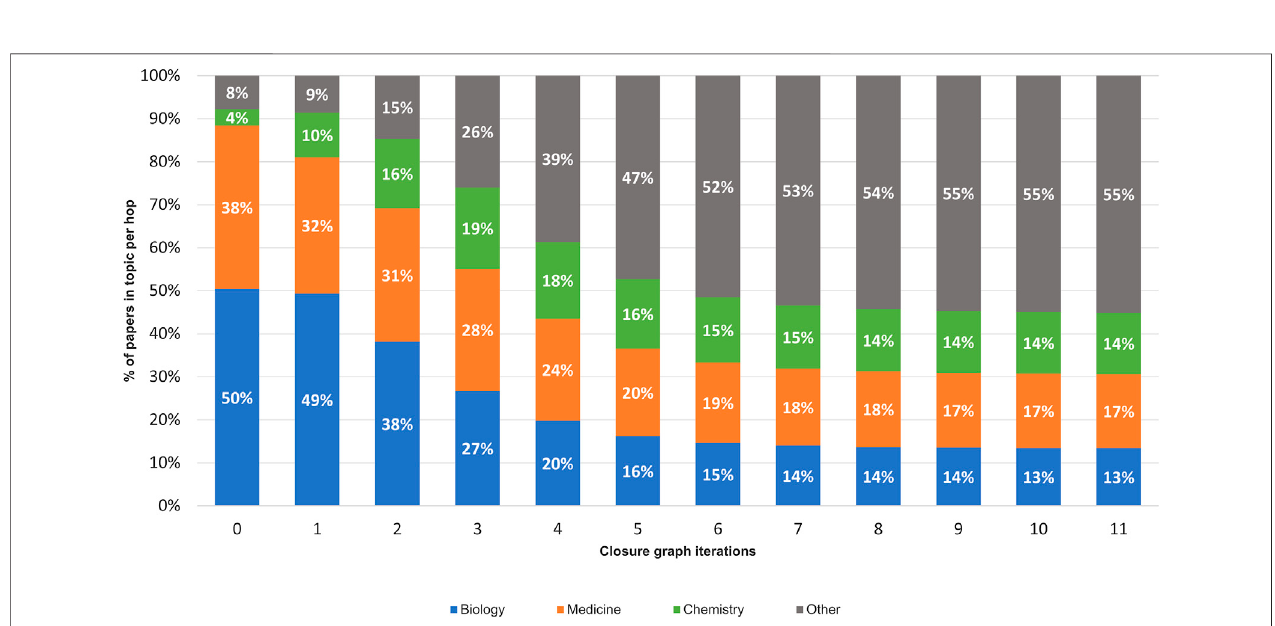
FIGURE 4 | Distribution of the top three high-level fi elds of study using Microsoft Academic Graph fi eld stamping algorithm (Shen et al., 2018) on each expansion hop of the closure graph.